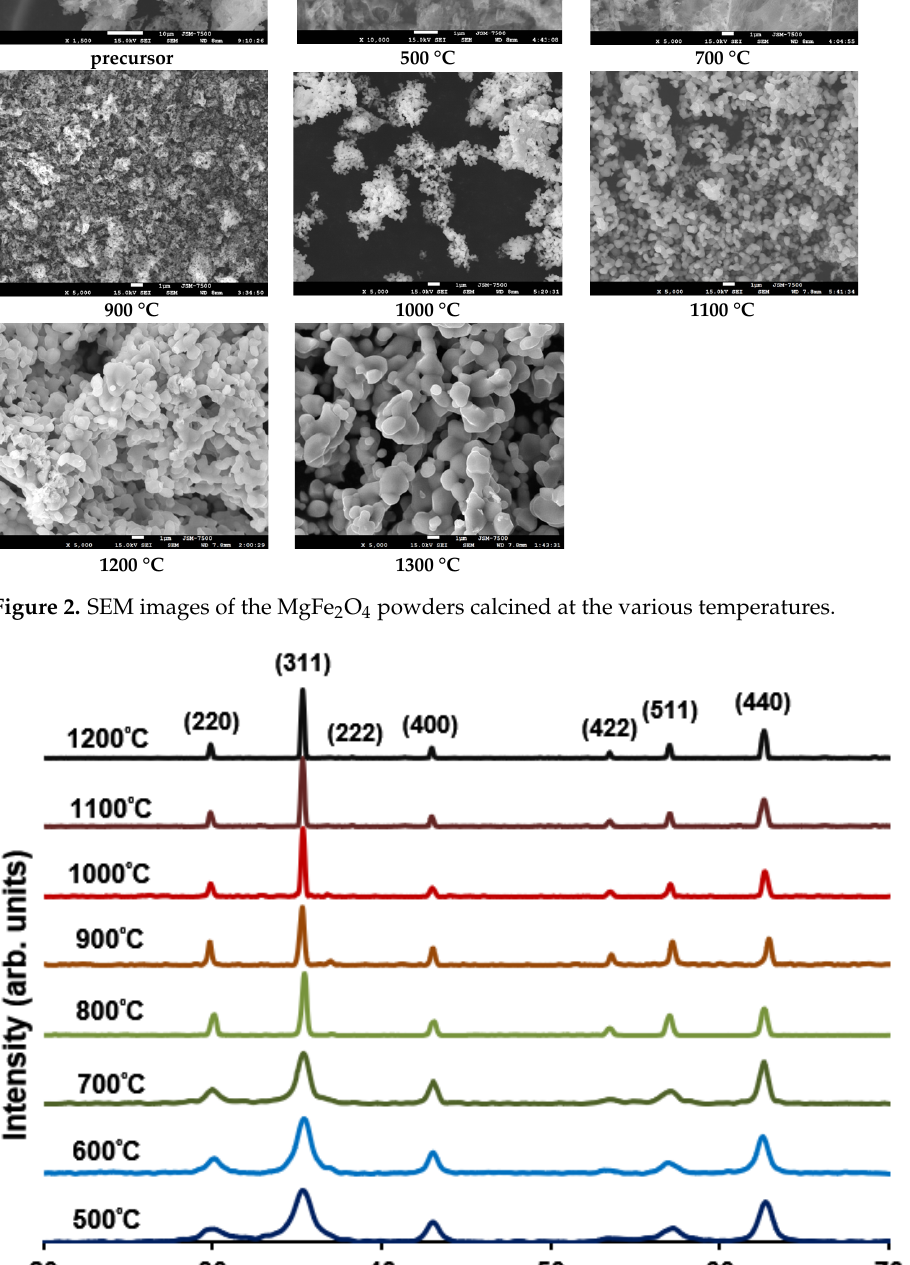
Figure 4. DC electrical conductivity of MgFe 2 O 4 powders for samples calcined at different temper- atures. 3.4. EDX Analysis Figure 5 shows the results of energy-dispersive X-ray elemental microanalysis of MgFe 2 O 4 powder calcined at 1200 °C.